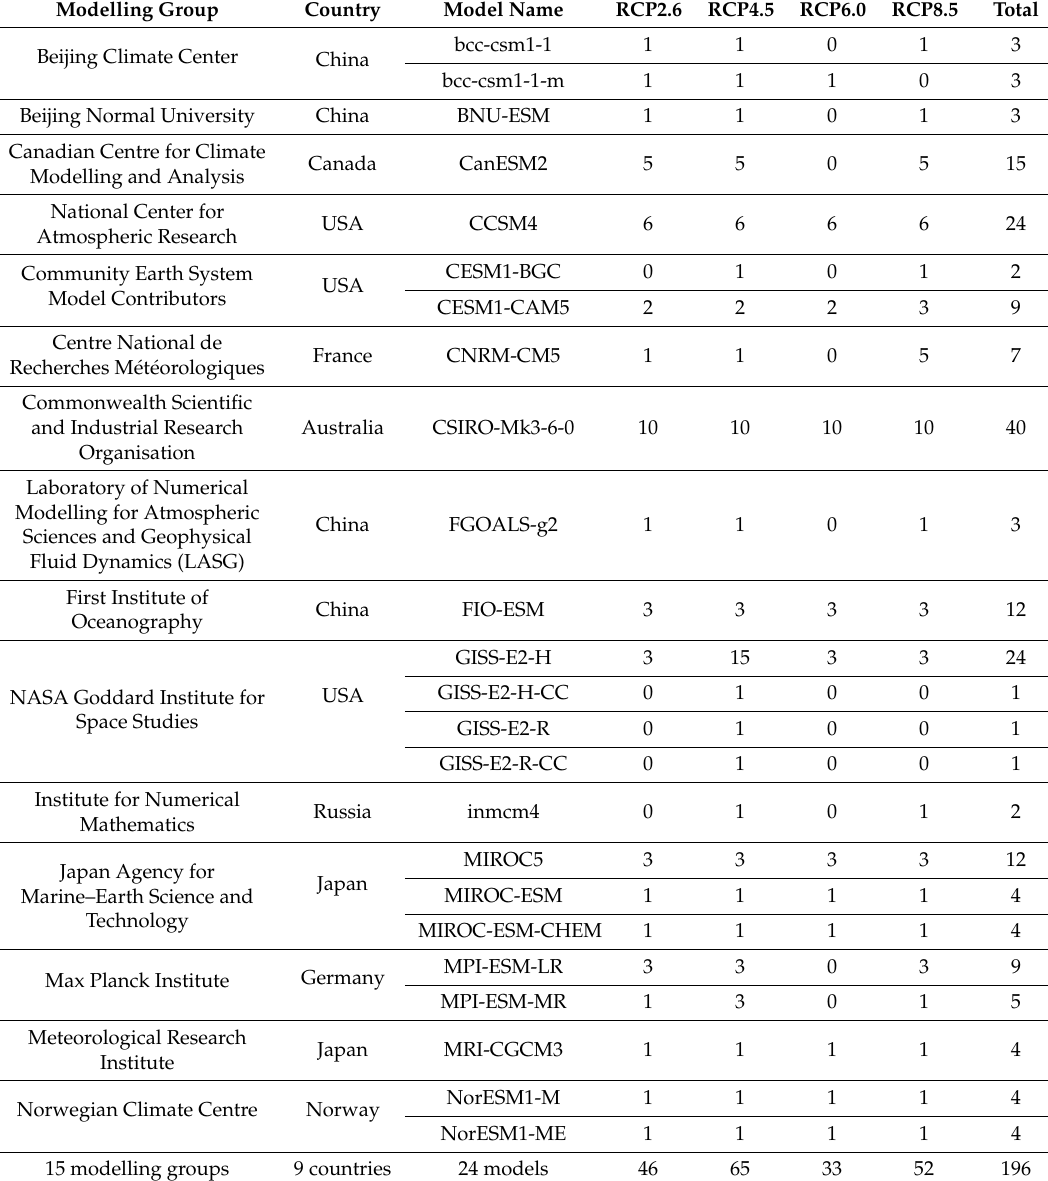
Table 1. All Coupled Model Intercomparison Project Phase 5 (CMIP5) climate model runs used for the analysis in this article. These corresponded to the models that provided snow cover